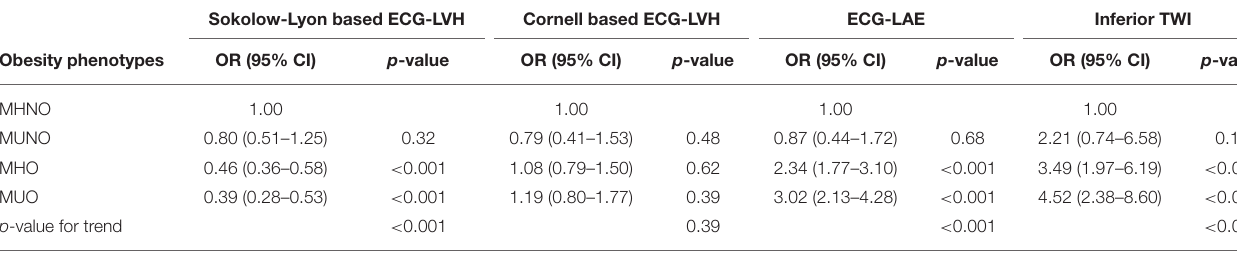
TABLE 3 | Associations of obesity phenotypes with ECG-LVH, ECG-LAE and inferior TWI. Sokolow-Lyon based ECG-LVH Cornell based ECG-LVH ECG-LAE